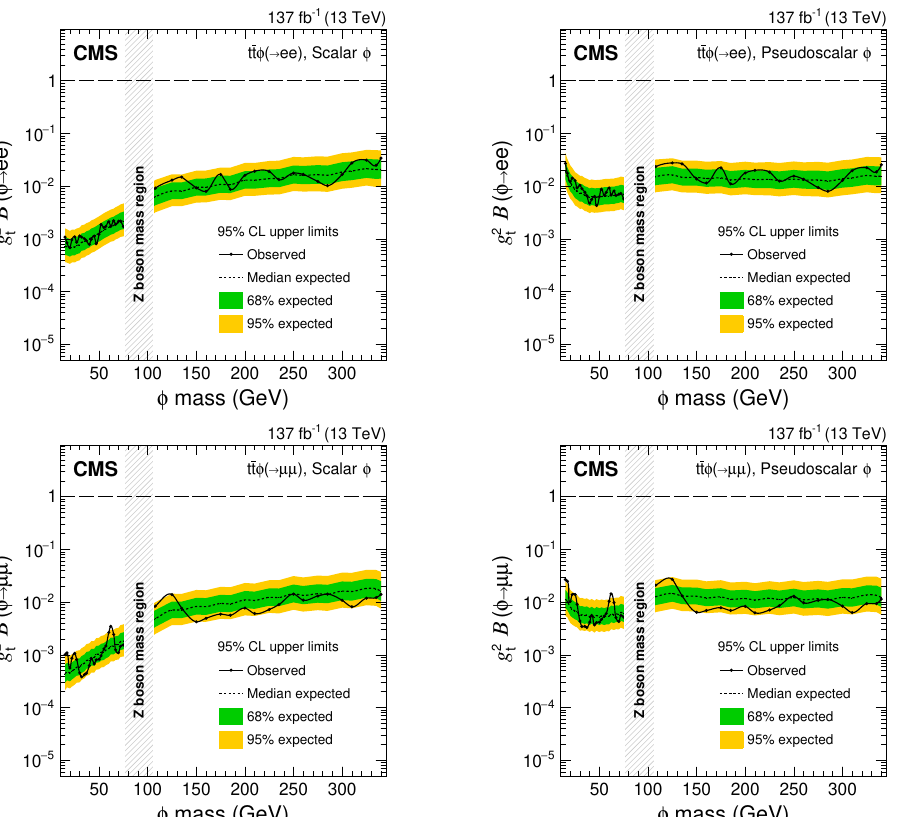
Figure 13 . The 95% con(cid:12)dence level expected and observed upper limits on the product of the square of the Yukawa coupling to top quarks and branching fraction of a scalar (cid:30) boson in the dielectron (upper left) and dimuon (lower left) channels, and of a pseudoscalar (cid:30) boson in the dielectron (upper right) and dimuon (lower right) channels, where (cid:30) is produced in association with a top quark pair. The inner (green) and the outer (yellow) bands indicate the regions containing 68 and 95%, respectively, of the distribution of limits expected under the background-only hypothesis. The vertical hatched gray band indicates the mass region corresponding to the Z boson veto. The dashed horizontal line marks the unity value of the product of the square of the Yukawa coupling to top quarks and the branching fraction. Assuming a Yukawa coupling of unit strength to top quarks, the branching fraction of new scalar (pseudoscalar) bosons to dielectrons or dimuons above 0.0004{0.004 (0.004{0.03) are excluded for masses in the range of 15{75 GeV, and above 0.004{0.04 (0.006{0.03) for masses in the range of 108{340